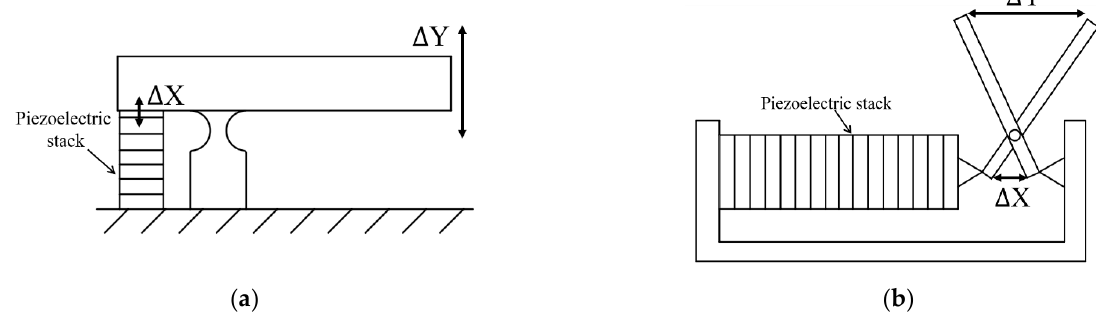
Figure 7. The output is in the same direction as the input: ( a ) lever mechanism with a rigid arm and a flexure hinge; ( b ) X-frame/scissors mechanism.